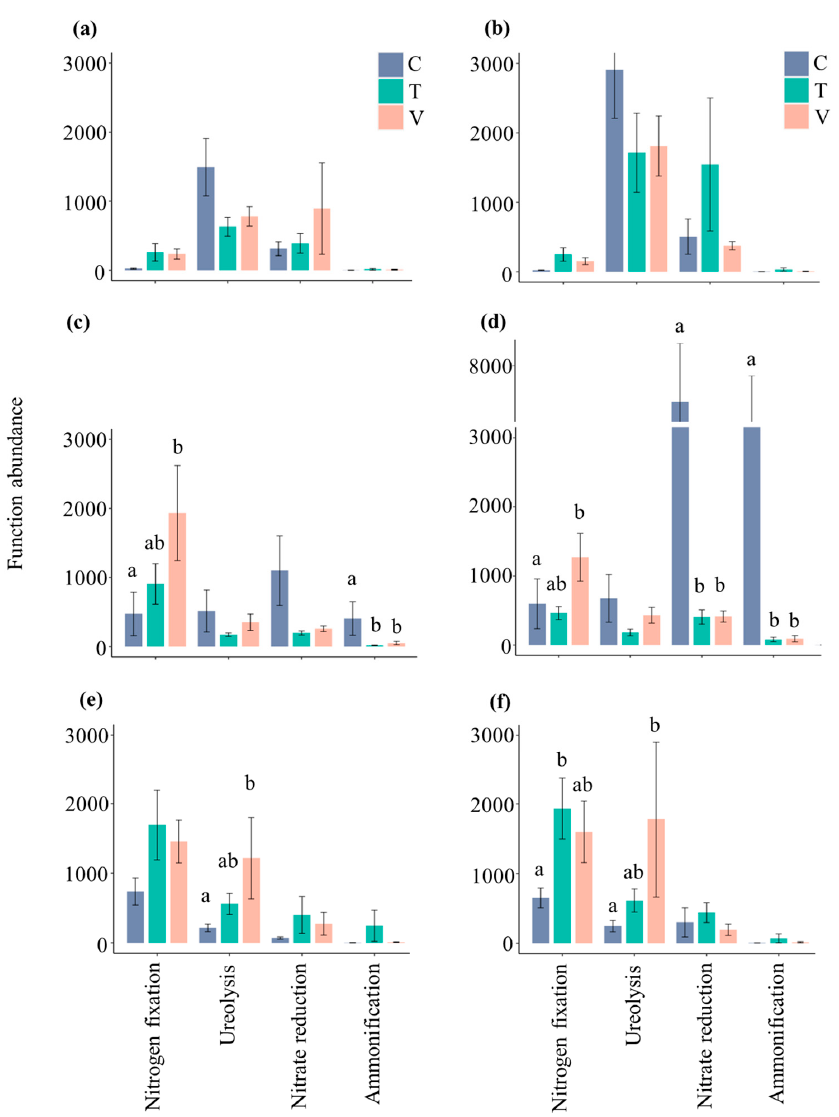
Figure 5. The columnar difference in bacterial functional groups related to the nitrogen cycle in leaf and stem litter. ( a ), leaf litter in spring; ( b ), stem litter in spring; ( c ), leaf litter in summer; ( d ), stem litter in summer; ( e ), leaf litter in autumn; ( f ), stem litter in autumn. All data are presented as the mean ± SE. Significant ( p < 0.05, Tukey’s test) differences among treatments are indicated by letters above the bars. The figure shows the more than 95% of the abundance of bacteria functional